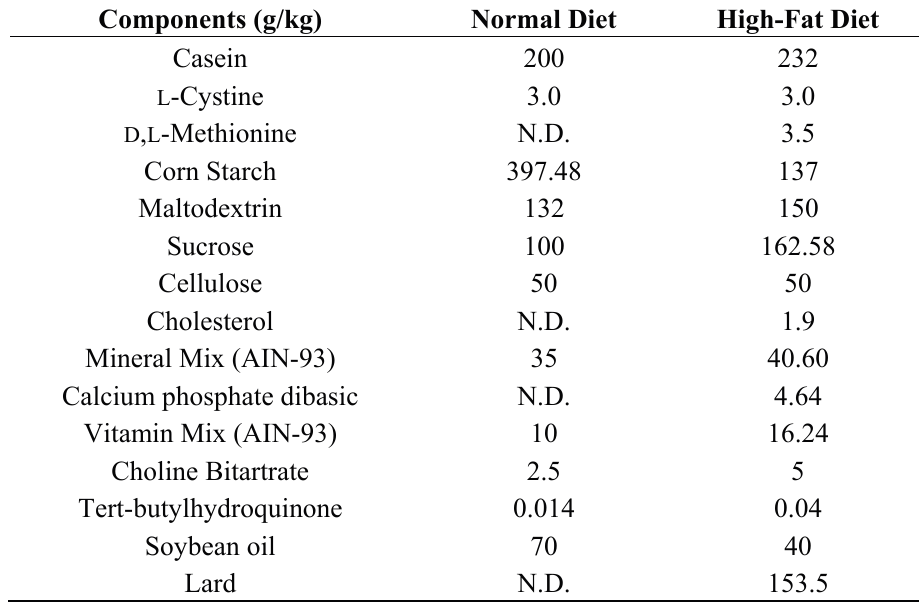
Table 2. Components of the normal diet and high-fat